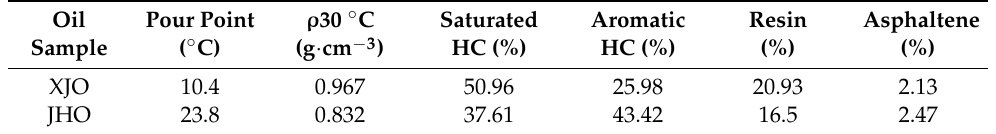
Table 1. Physical parameters of crude